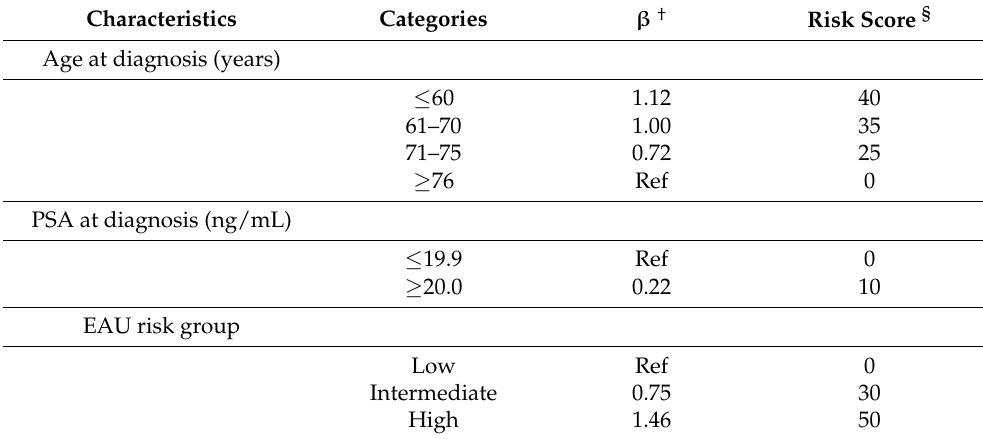
Table 3. Scoring rules for constructing the simplified risk score at diagnosis for PCa survival based on the complementary log–log regression model among PCa-diagnosed cases in the control arm.